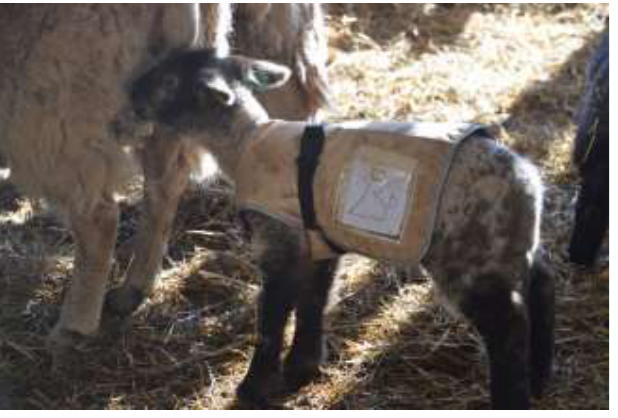
Figure 3. Lamb in jacket approaching two weeks of age; note the jackets appear short at that age but still functional.